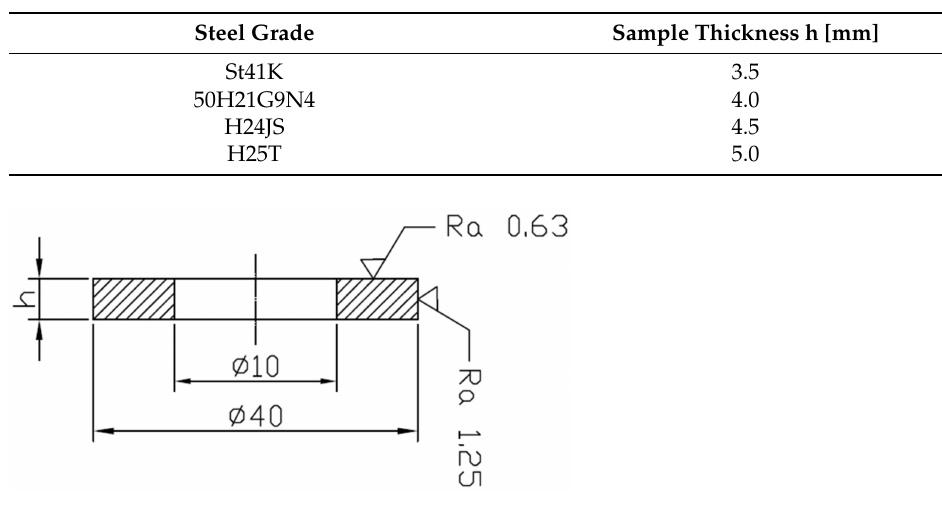
Table 4. Thickness h of samples, which were steel plates, depending on the type of material.